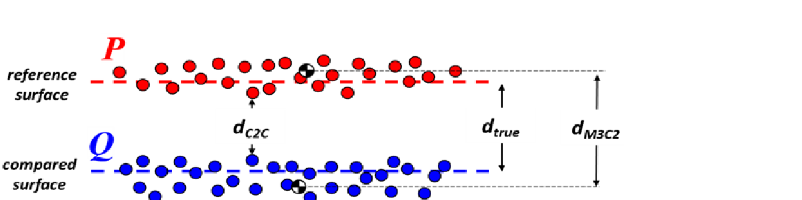
Figure 13. Example disposition of point cloud noise that can lead to disagreement in deformation tracking